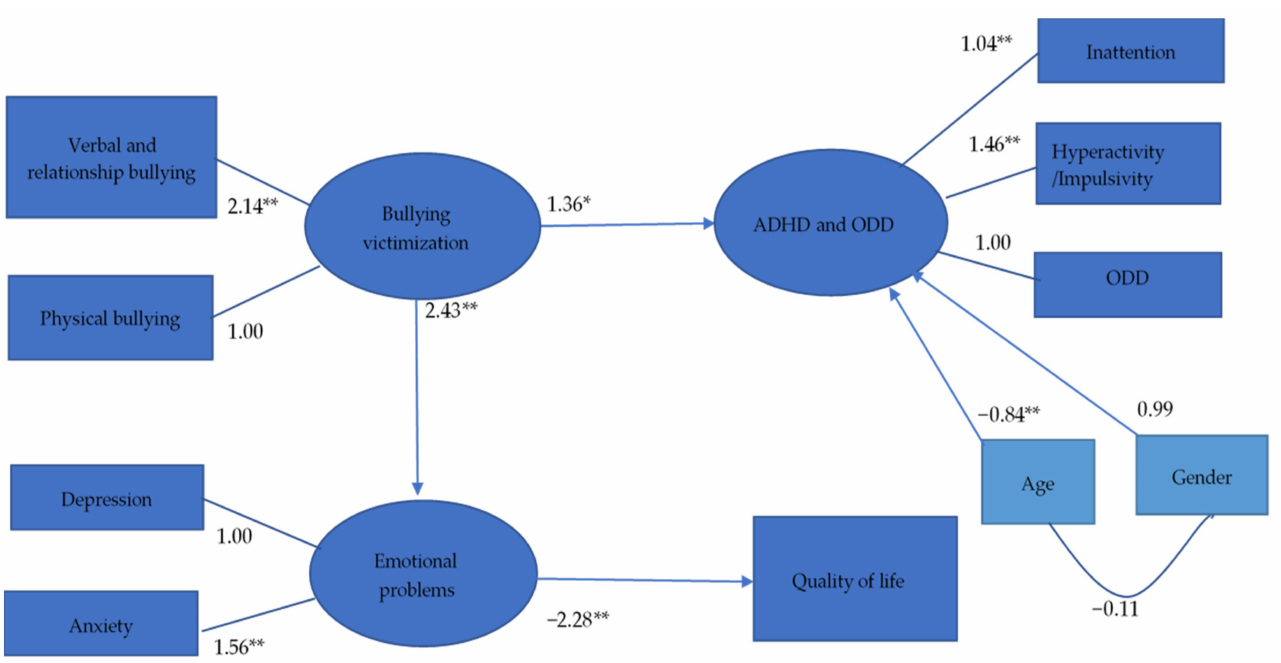
Figure 2. Unstandardized coefficients in hypothesized model. ADHD: Attention-deficit/hyperactivity disorder; ODD: Oppositional defiant disorder. * p < 0.05; ** p < 0.01.